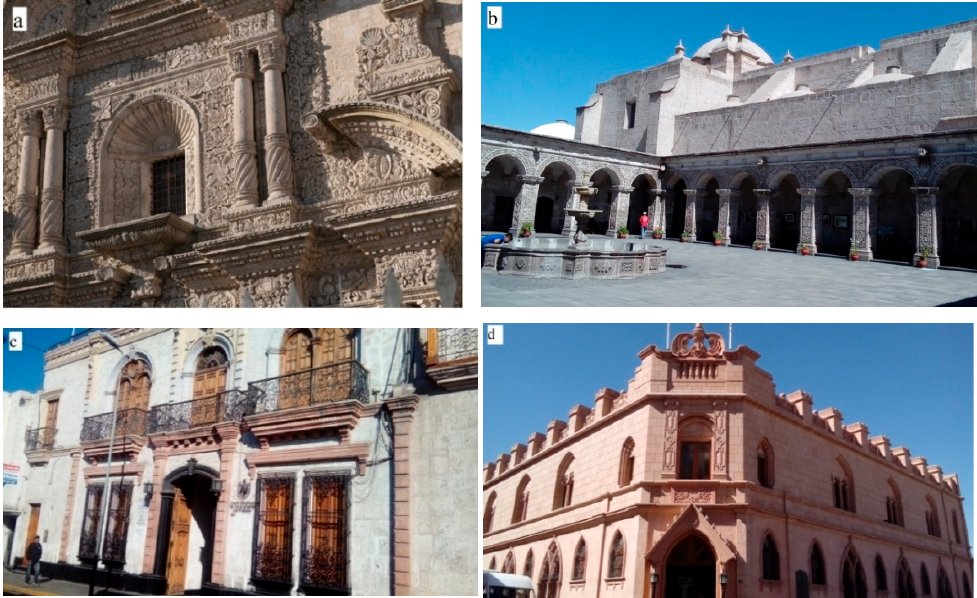
Figure 1. ( a ) Carved white ignimbrite façade of La Compañía de Jesús church, ca. 1698; ( b ) restored cloister after 1960 earthquake; ( c ) pink ignimbrite pilasters, corbels and moldings; ( d ) neogothic Bishop’s Palace (the latter two from the first quarter of the 20th century).